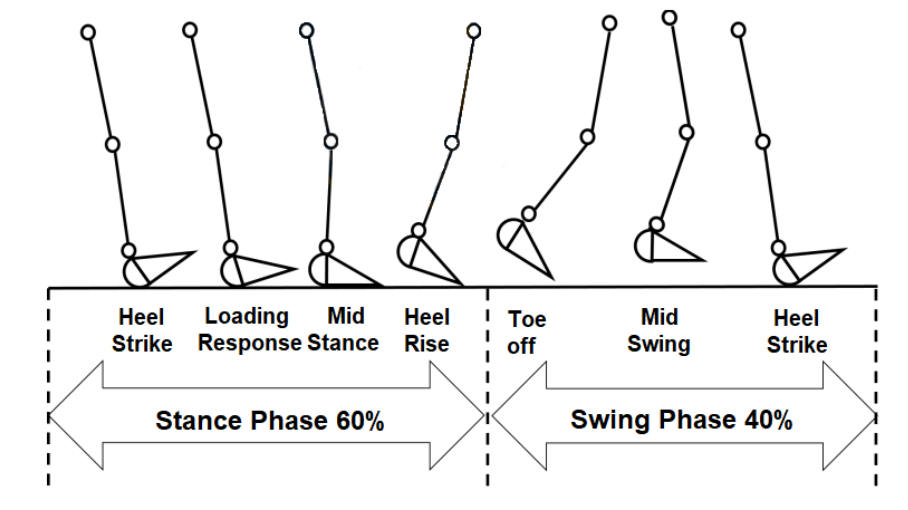
Figure 1. The gait cycle and gait